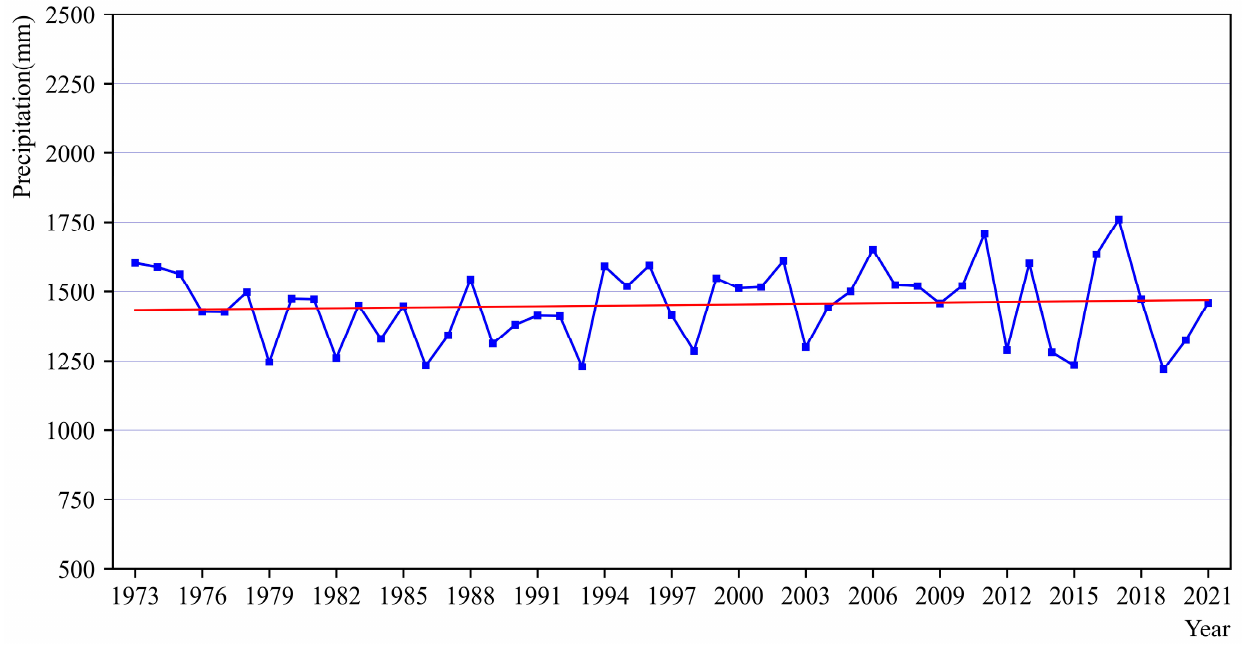
Figure 9. The interannual variability of precipitation in the Salween River Basin from 1973 to 2021.